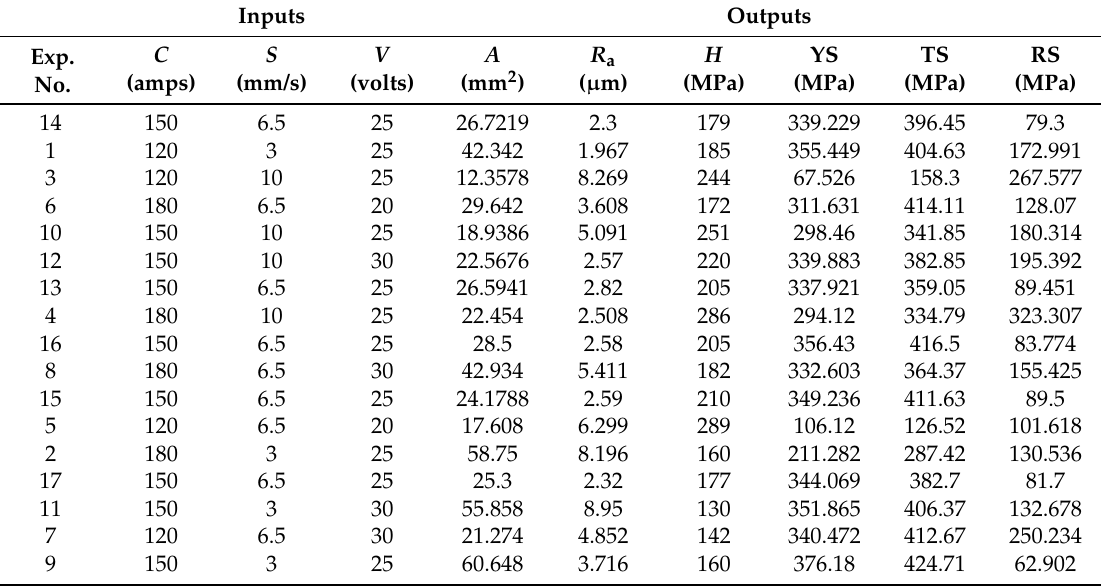
Table 2. Design matrix and specimens obtained by BBD. A , area of the weld cord; H , hardness; YS, yield strength; TS, tensile strength; RS, residual stress. Inputs Outputs